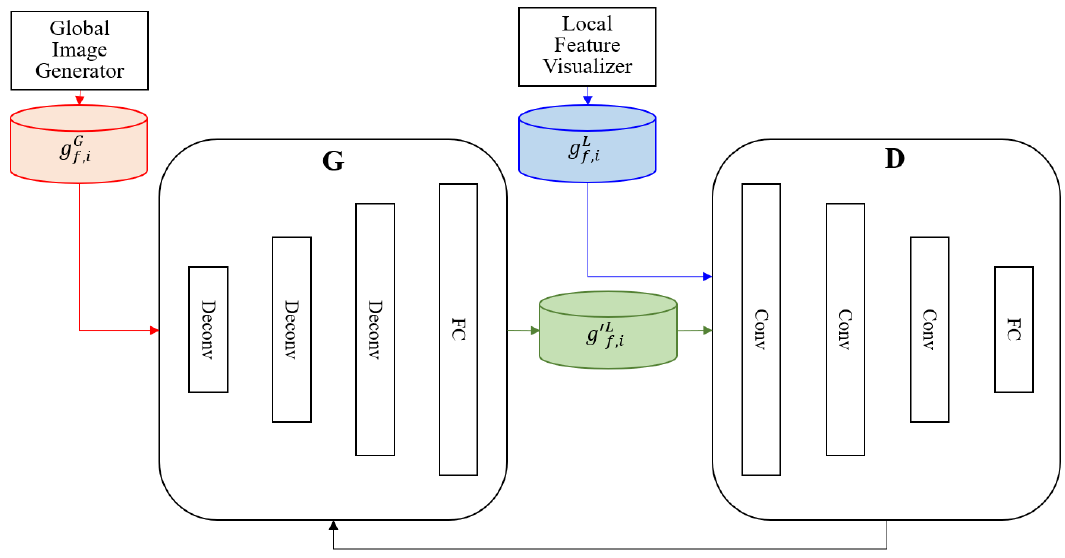
Figure 3. General adversarial network (GAN) training process. Deconv is deconvolution, Conv is convolution and FC is fully connected.